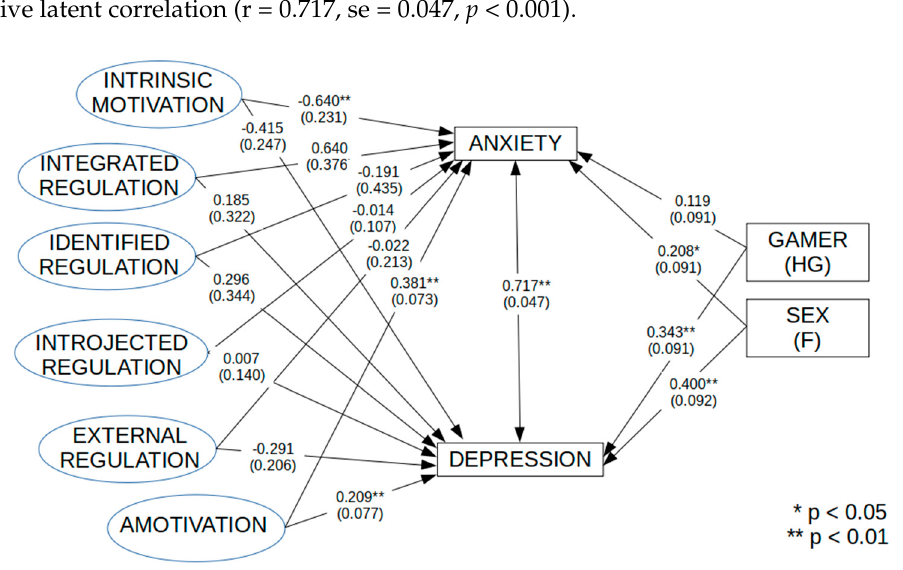
Figure 1. Path Model of the effects (completely standardized regression coefficients) of GAMS latent factors on Depression (CES-D scores) and Anxiety (STAI scores). Table 4. Effects (Completely standardized regression coefficients) of GAMS latent factors on the CES-D and STAI scores (N =